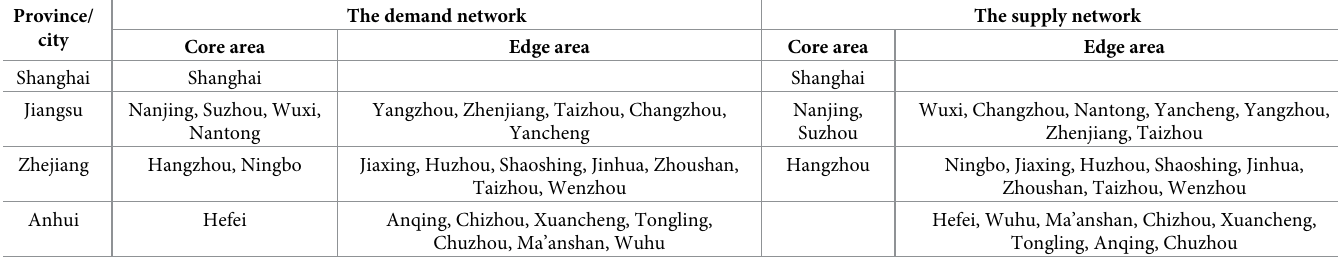
Table 2. Core–edge structure of the demand and supply